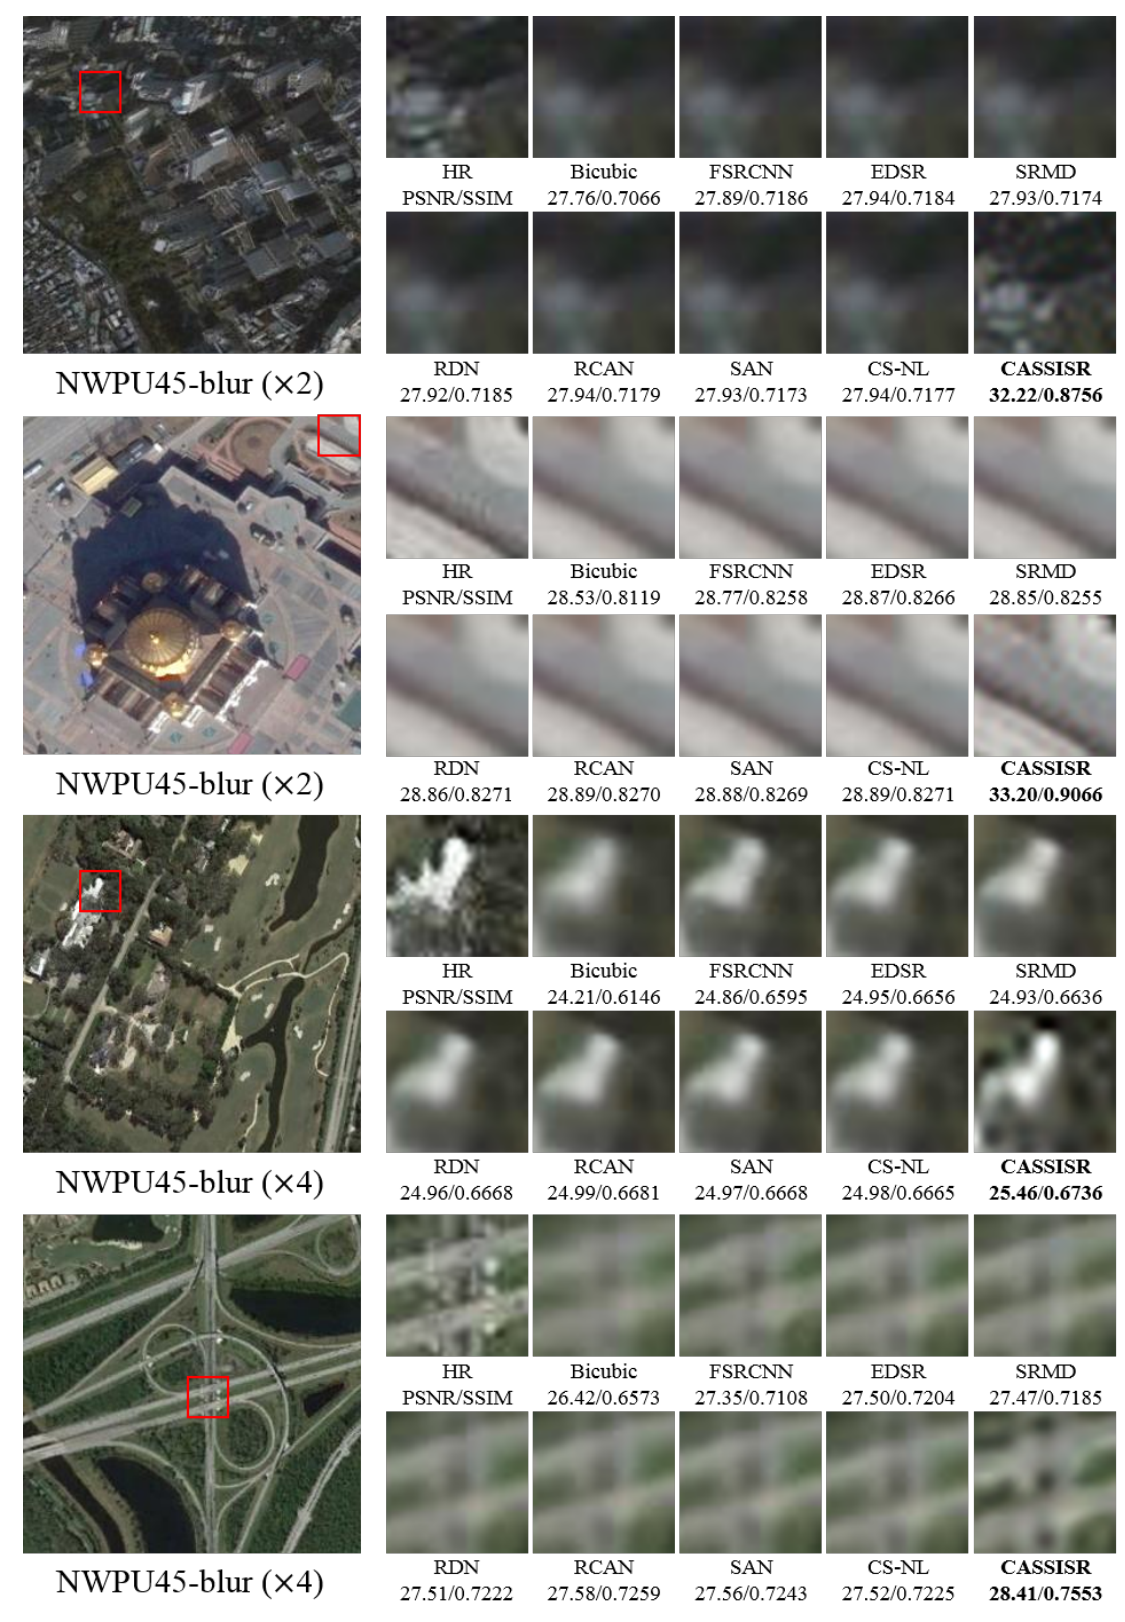
Figure 9. Qualitative comparison of scaling factors × 2 and × 4 between CASSISR and CNN-based SR methods on NWPU45- blur dataset. Our CASSISR results are highlighted